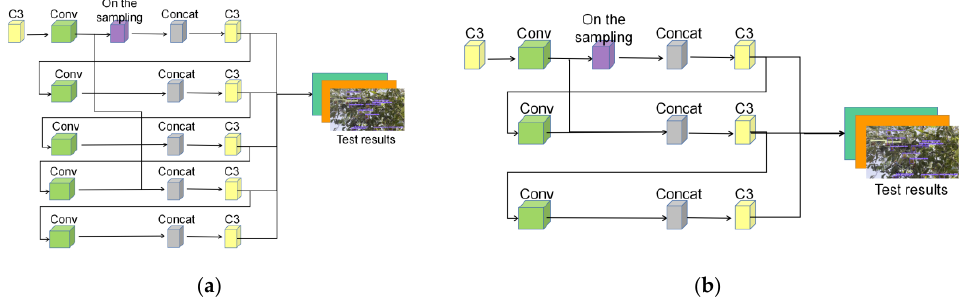
Figure 10. Comparison of the YOLOv5 output layers before and after adding a small target detection layer. ( a ) YOLOv5 output layer. ( b ) Model output layer after adding a small target detection layer.